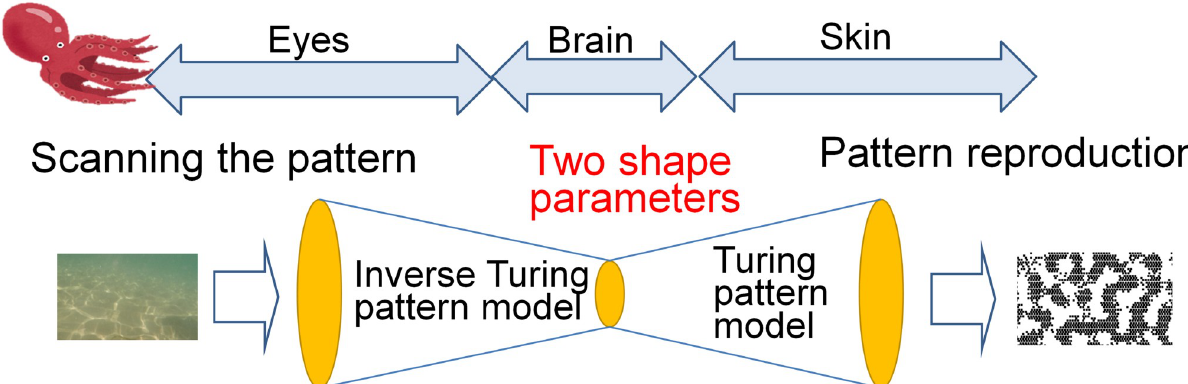
Fig 1. Outline of the model of octopus epidermis pattern mimicry. The mechanism of octopus skin pattern formation was assumed to be analogous to the Turing model and a cellular automaton. An inverse calculation model was proposed using the characteristics of the cellular Turing pattern model where two features are extracted from the Turing pattern